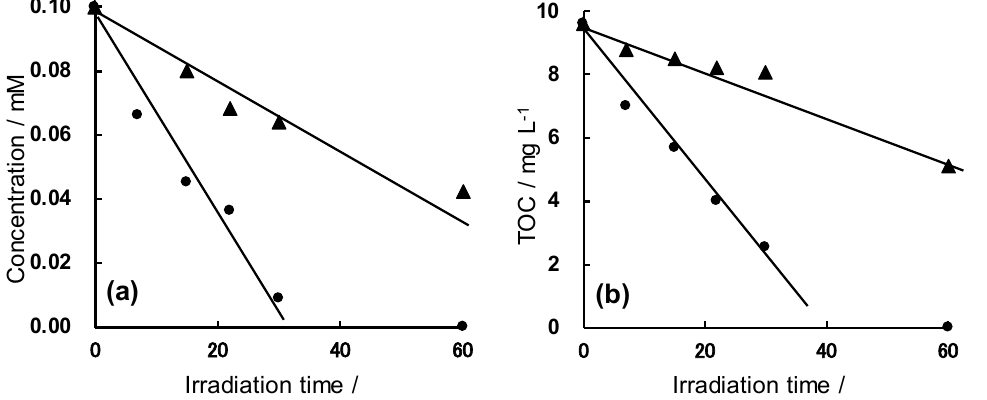
Figure 4. Disappearance of ( a ) UV absorption and ( b ) TOC in the photodegradation of 2,4-D by the UV and UV/MW methods. Reproduced from [33]. Copyright 2007 by Elsevier